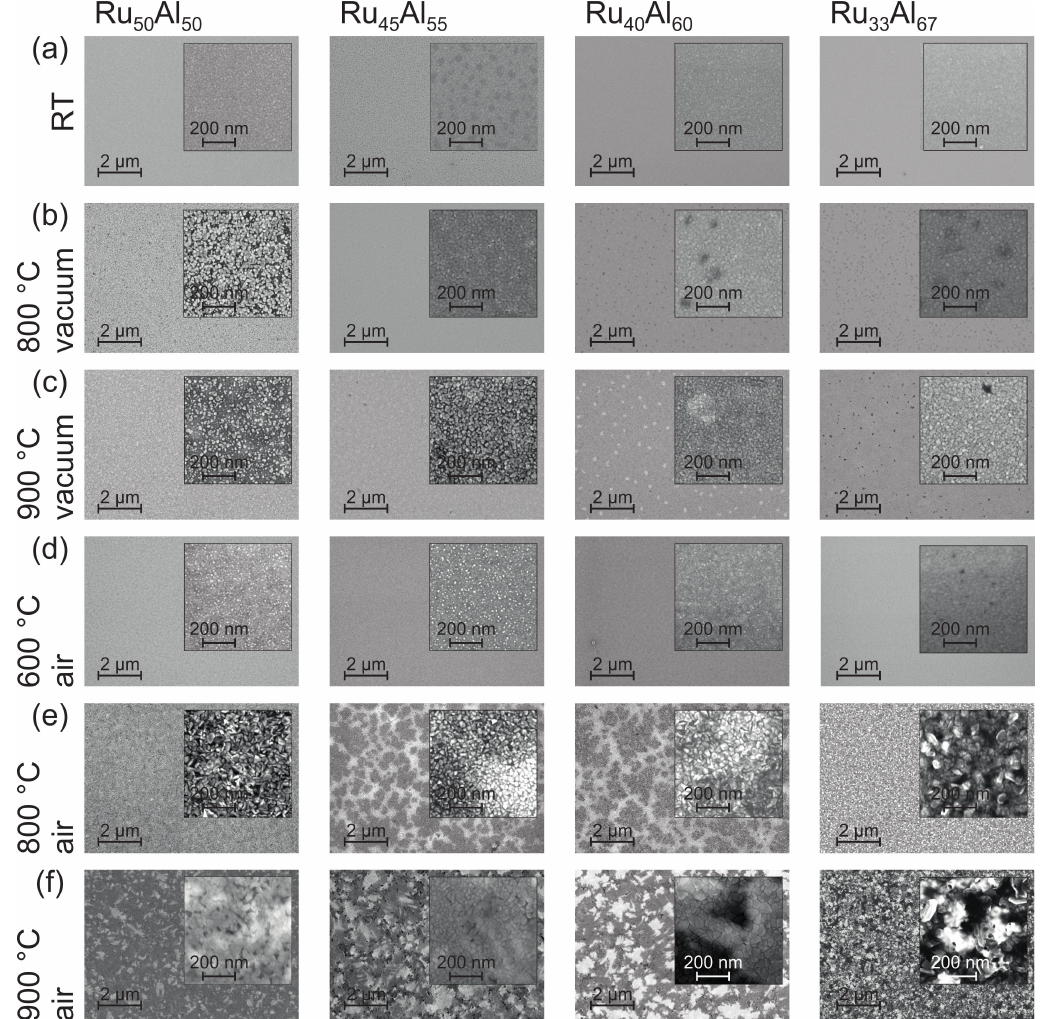
Figure 2. Scanning electron microscopy (SEM) inLens (20 kV) images showing the surface morphology of the samples with the different compositions Ru 50 Al 50 , Ru 45 Al 55 , Ru 40 Al 60 and Ru 33 Al 67 ( a ) after preparation and after heat treatment for 10 h at ( b ) 800 ◦ C; ( c ) 900 ◦ C under high vacuum, as well as ( d ) 600 ◦ C; ( e ) 800 ◦ C and ( f ) 900 ◦ C in